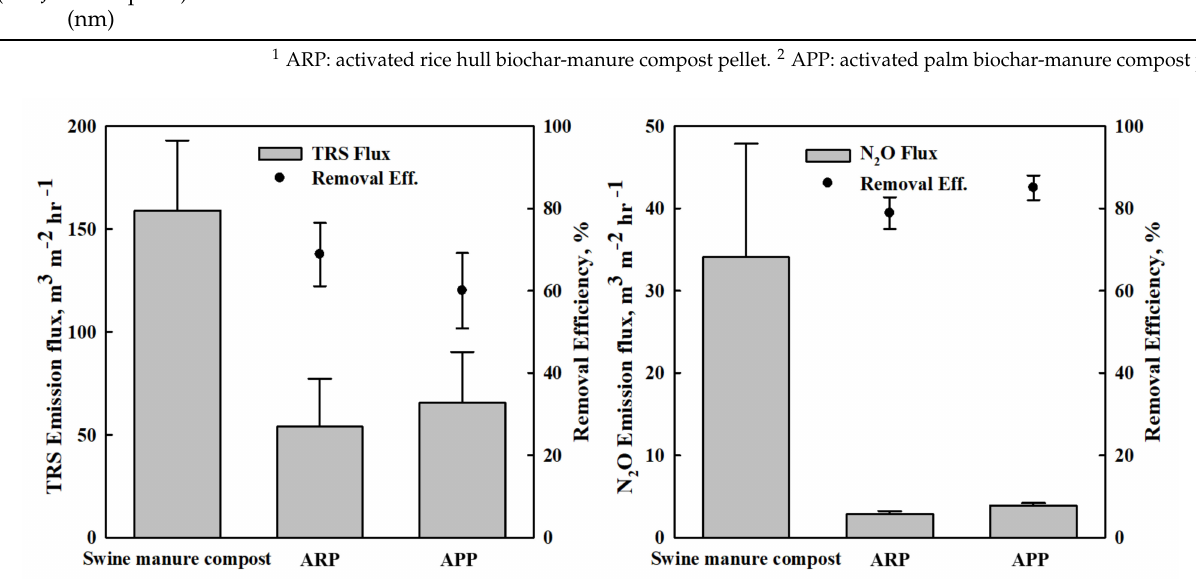
Figure 4. Total reduced sulfur (TRS) and N 2 O flux from swine manure compost and ABMCP. Error bars indicate standard error. ARP: activated rice hull biochar-manure compost pellet. APP: activated palm biochar-manure compost